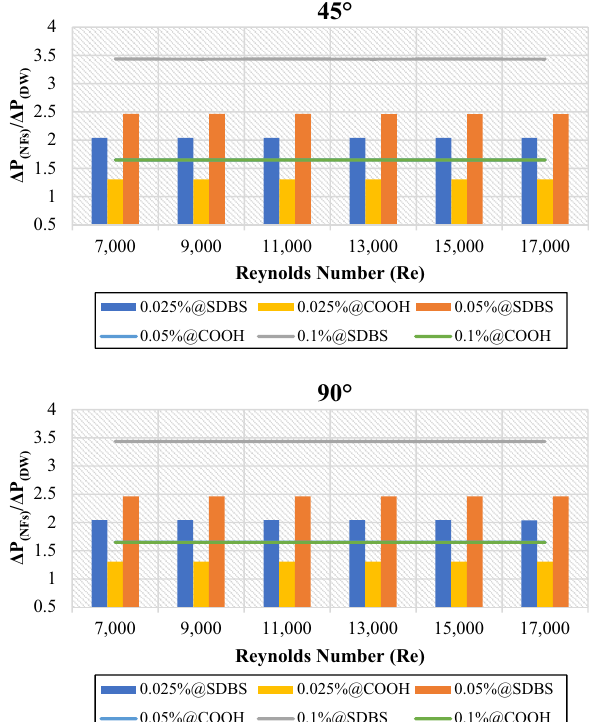
Figure 8. Pressure drops of nanofluids to base fluid versus Reynolds numbers for 45° and 90°